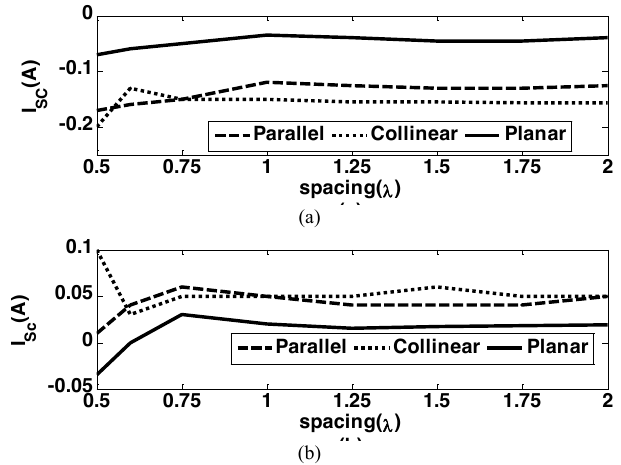
FIGURE 8. Short circuit current (A) of different arrangements of infinite array of straight wire antennas versus normalized spacing based on MoM, (a): real and (b): imaginary